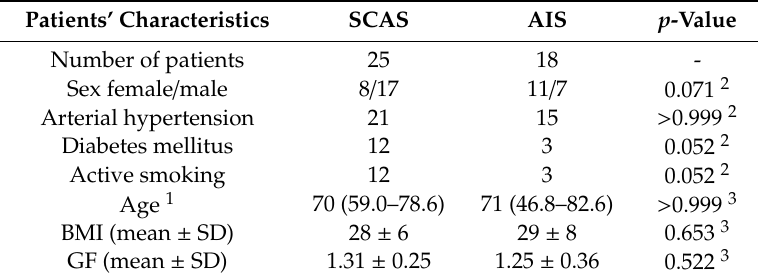
Table 2. Patients’